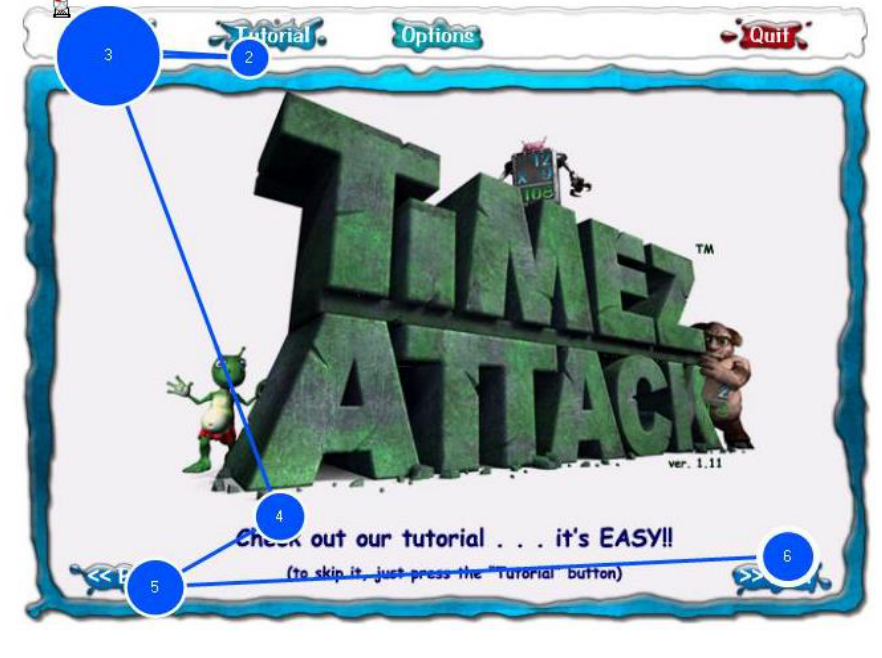
Figure 2 Fixations of a child novice on the opening